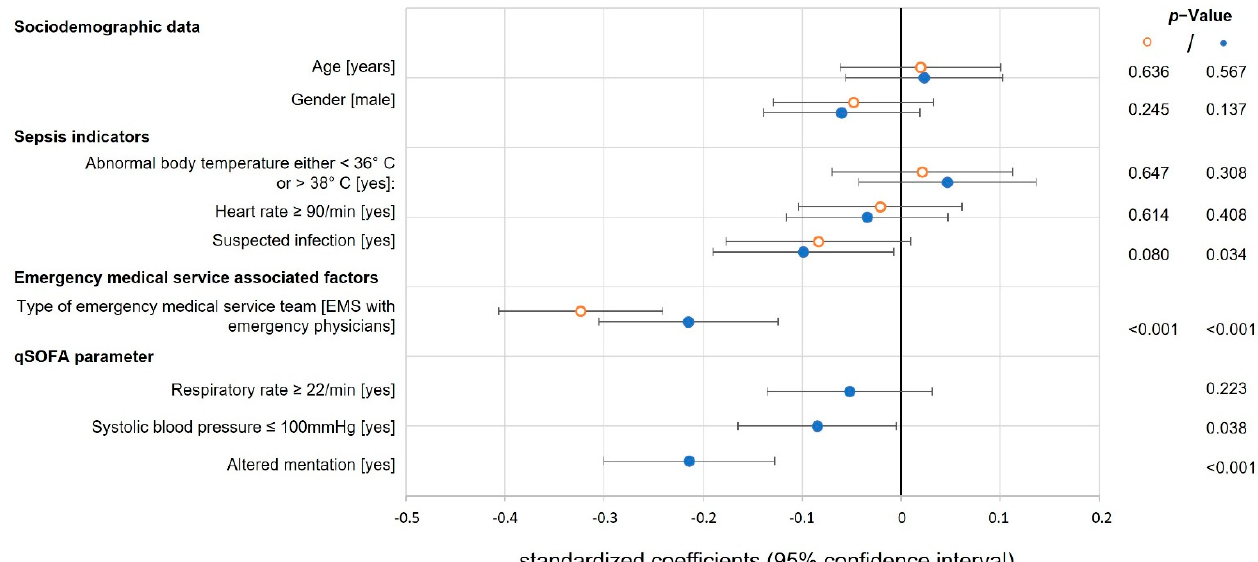
Figure 4. Time to fluid resuscitation. The forest plot shows the standardized coefficients with 95% CI (x-axis) and p -values for each covariable regarding the secondary endpoint ‘time to fluid resuscitation’ of two multiple linear regression models ( n = 702 cases): model without qSOFA (orange o dot) and model with additional qSOFA parameters (blue • dot); time is logarithmized; the vertical solid line marks a standard coefficient of zero, a shift to the right indicates a prolonged and to the left side a shortened ‘time to fluid resuscitation’; qSOFA: quick sequential organ failure assessment. Our data revealed an incremental value of qSOFA parameters for both linear regression models. When qSOFA parameters were added to the model, the explained